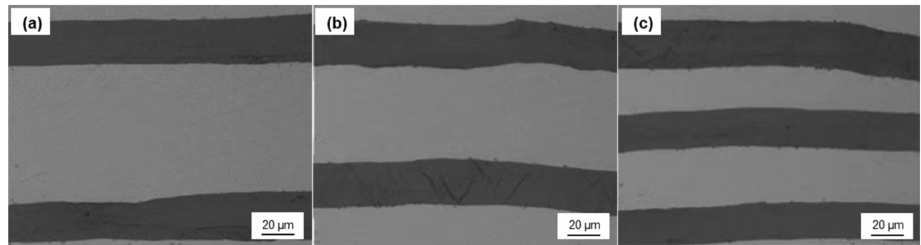
Figure 9. Optical microphotograph of the composite with different graphite volume fraction: ( a ) 11.1%; ( b ) 19.8%; ( c )